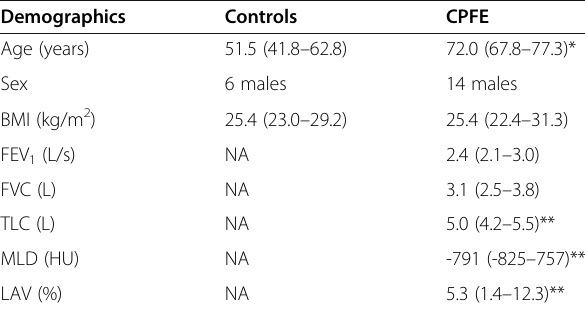
Table 1 Clinical characteristics of the study population